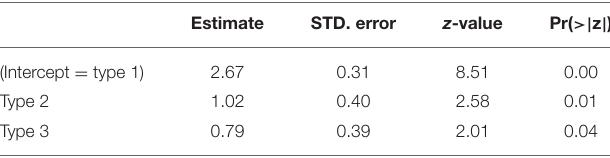
TABLE 5 | Logistic regression analysis of the accuracy of nonces in experiment 1. Estimate